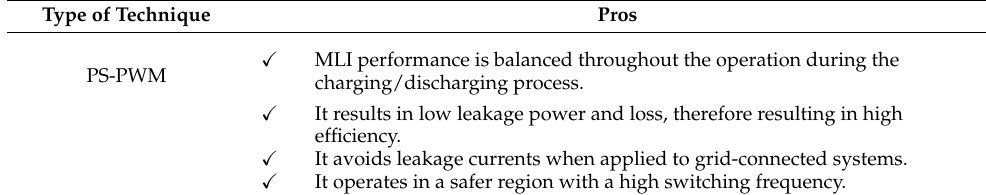
Table 4. PS-PWM technique